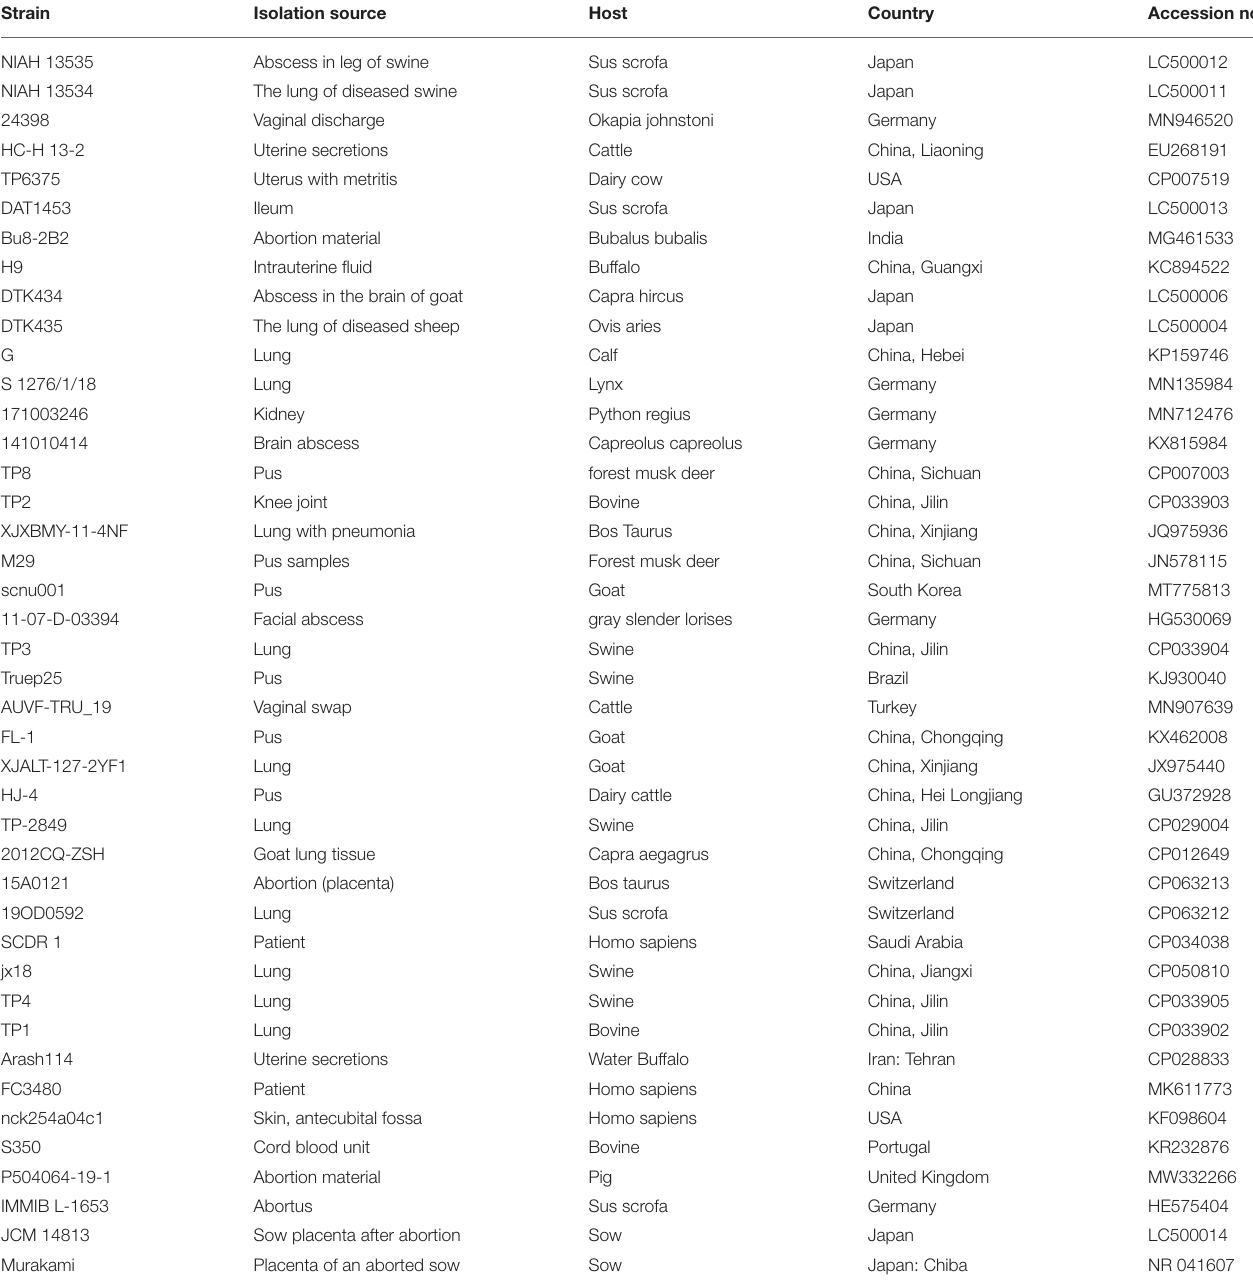
TABLE 2 | Trueperella pyogenes 16S rRNA genes referenced in this study.